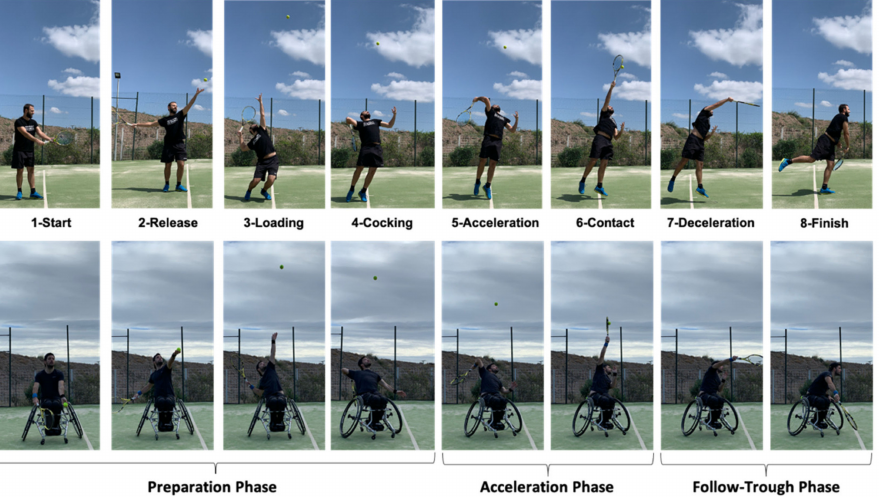
Figure 1. Service sequence in conventional and wheelchair